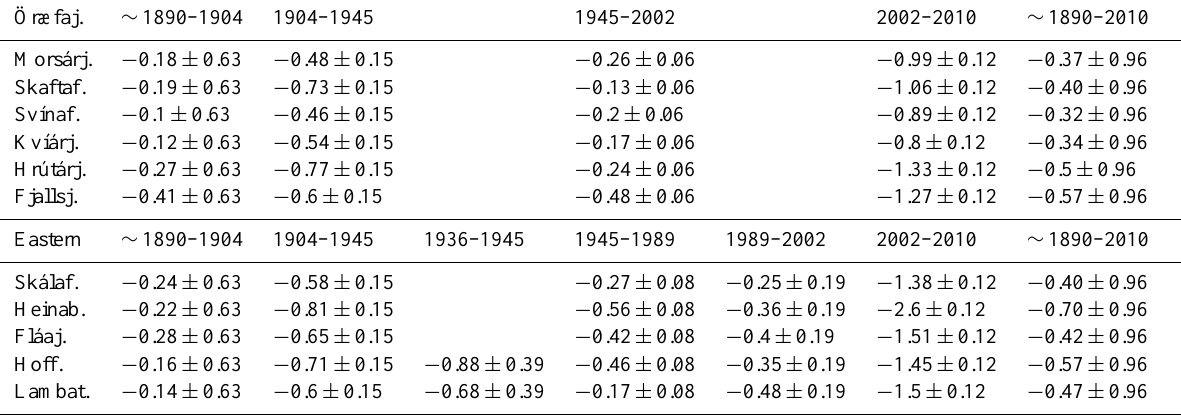
Table 5. Geodetic mass balance in m w.e.a − 1 for outlets of Öræfajökull (upper panel) and the eastern outlet glaciers (lower panel) for different time intervals.